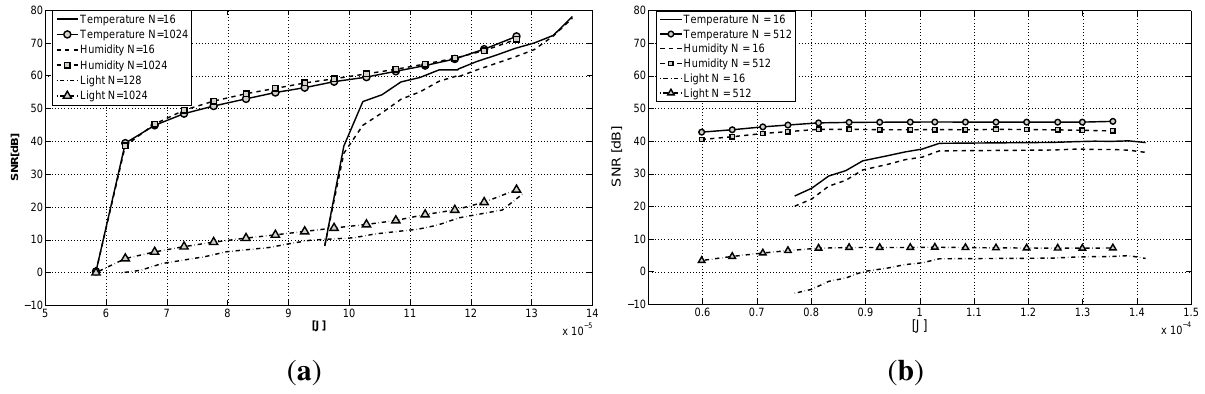
Figure 7. Reconstruction quality vs. averaged per cycle energy consumption varying the parameter N : ( a ) CS and ( b ) LV.